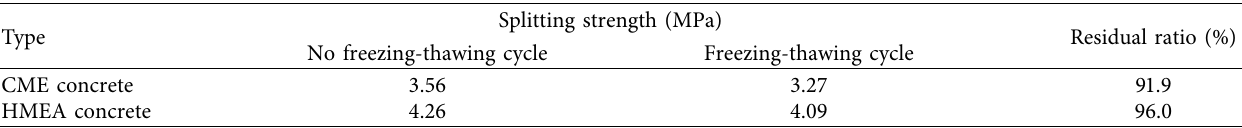
Table 12: Freeze-thaw splitting test results of CME and HMEA concretes.